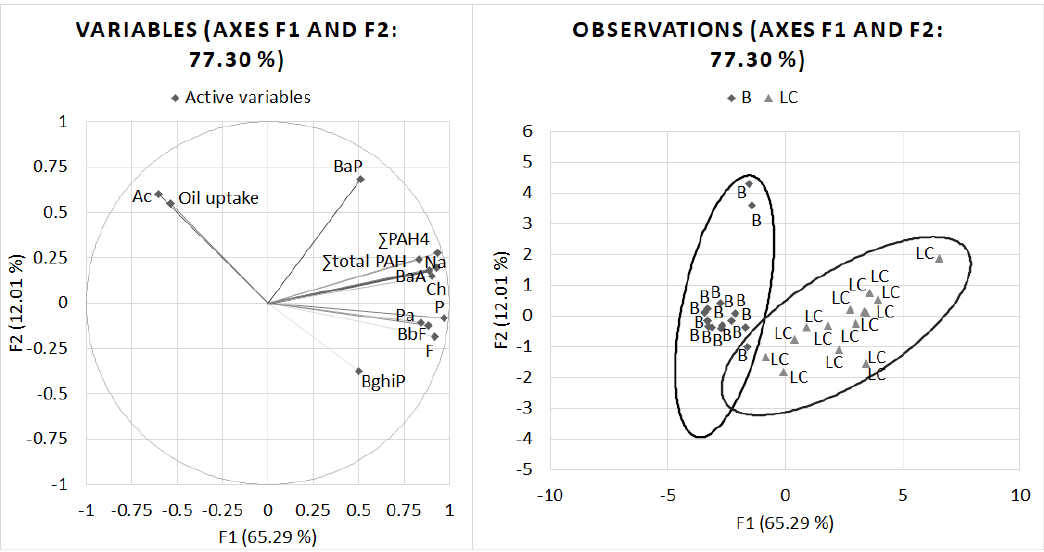
Figure 4. Principal components analysis (PCA)—Projection of active variables